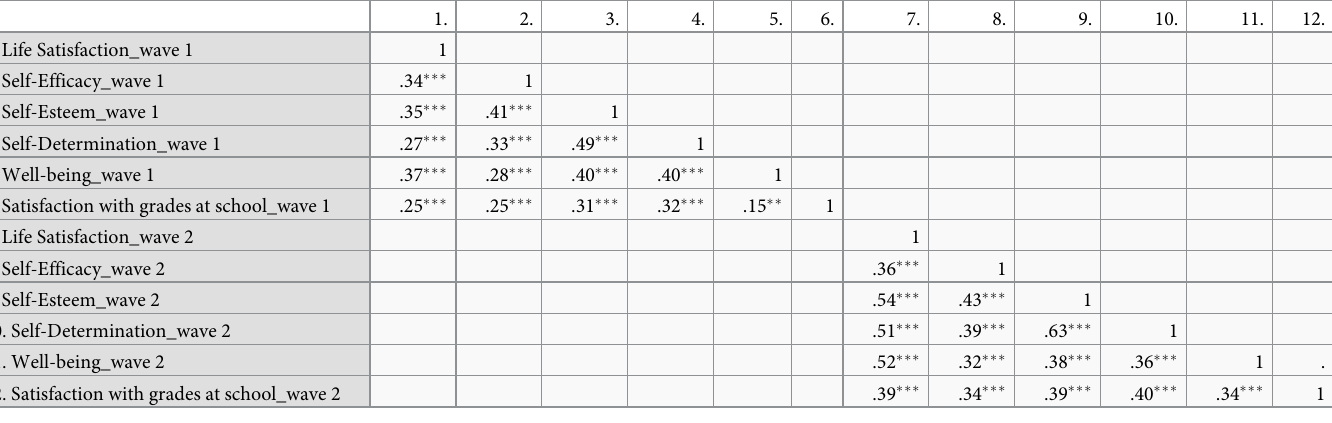
Table 2. Correlation between